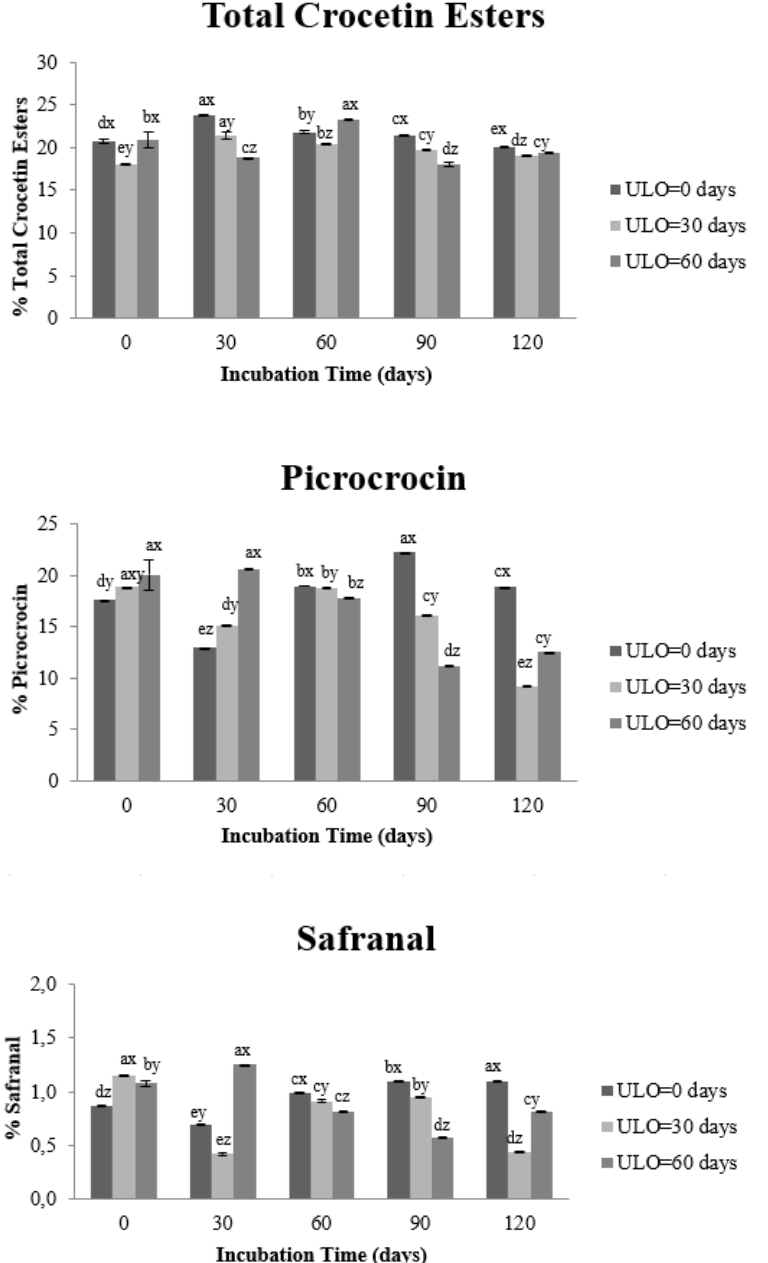
Figure 7. E ff ect of the di ff erent forcing conditions on the main sa ff ron metabolites. x, y, z , di ff erent letters Figure 7. Effect of the different forcing conditions on the main saffron metabolites. x, y, z , different letters within ULO time mean significant di ff erences ( p < 0.05); a, b, c, d, e , di ff erent letters within incubation within ULO time mean significant differences ( p < 0.05); a, b, c, d, e , different letters within incubation time mean significant di ff erences ( p < time mean significant differences ( p < 0.05).